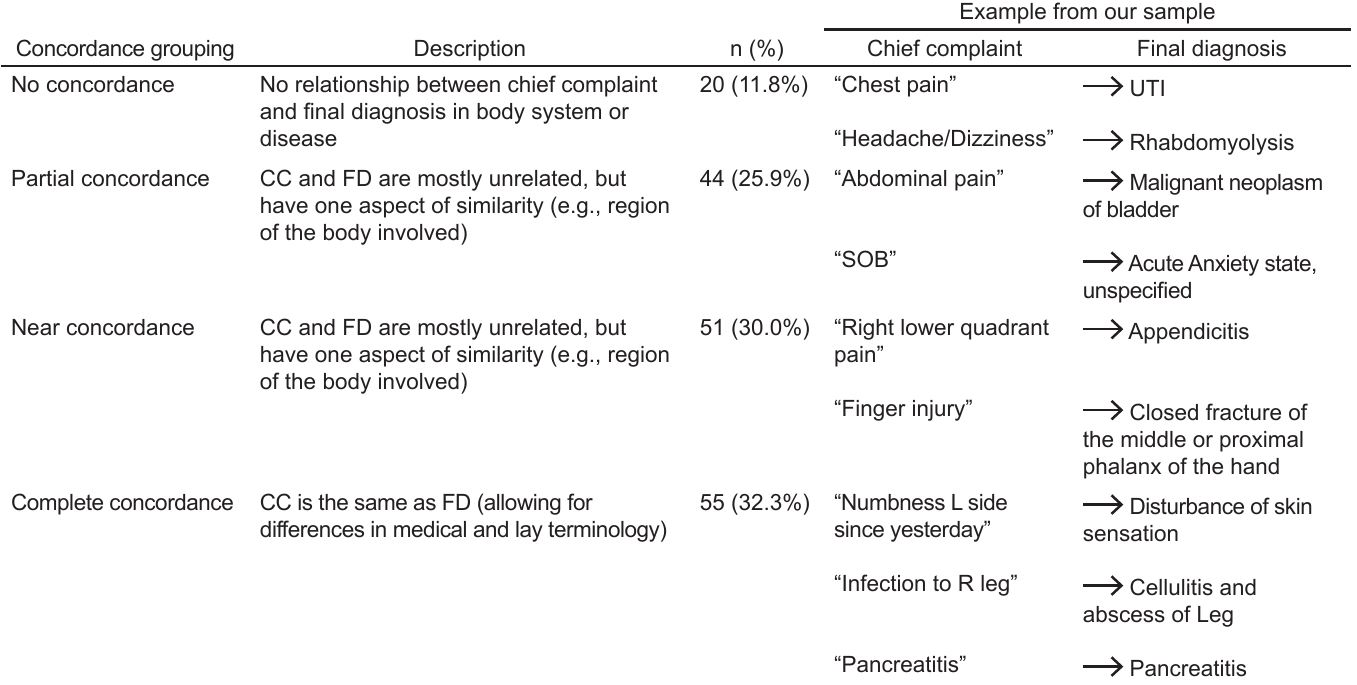
CC , chief complaint; FD , final diagnosis; L , left; R , right; SOB , shortness of breath; UTI , urinary tract